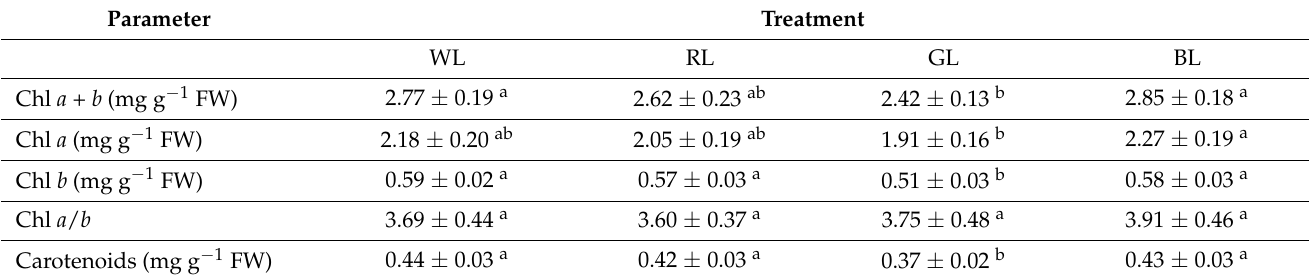
Table 3. The abundance of photosynthetic pigments extracted with DMSO from 3-mm leaf discs of tomato plants grown under different light conditions: WL—the R:G:B = 1:1:1 at 120 µ mol m − 2 s − 1 ; RL, GL or BL—monochromatic red (R), green (G) or blue (B) light (L) at 80 µ mol m − 2 s − 1 , respectively. The presented values are means of ten replicates ± SD. Different letters in the same row indicate significant differences between treatments at p = 0.05 with a Tukey’s HSD test.